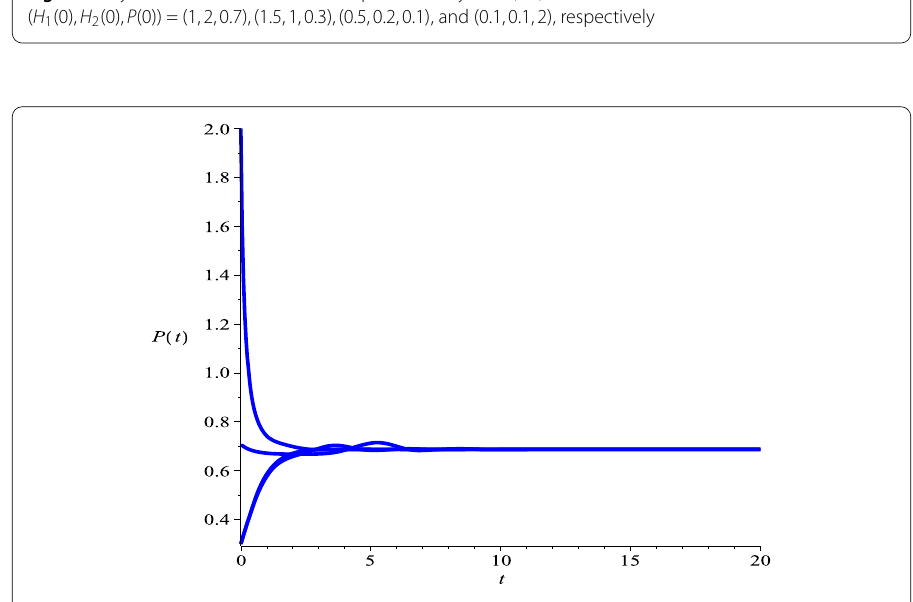
Figure 9 Dynamic behaviors of the second species in system (5.6). The initial conditions ( H 1 (0), H 2 (0), P (0)) = (1,2,0.7),(1.5,1,0.3),(0.5,0.2,0.1), and (0.1,0.1,2), respectively